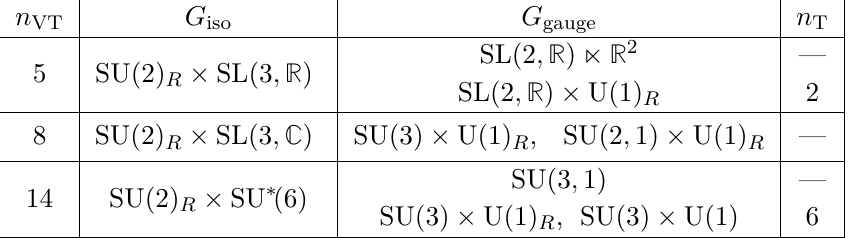
Table 3 . Maximal reductive and compact gauge groups in the special cases of purely vector/tensor multiplet truncations. The first column gives the total number of vectors and tensor multiplets, the second the global isometry group, the third the allowed gaugings and the last one the number of vectors that are dualised to tensors in each